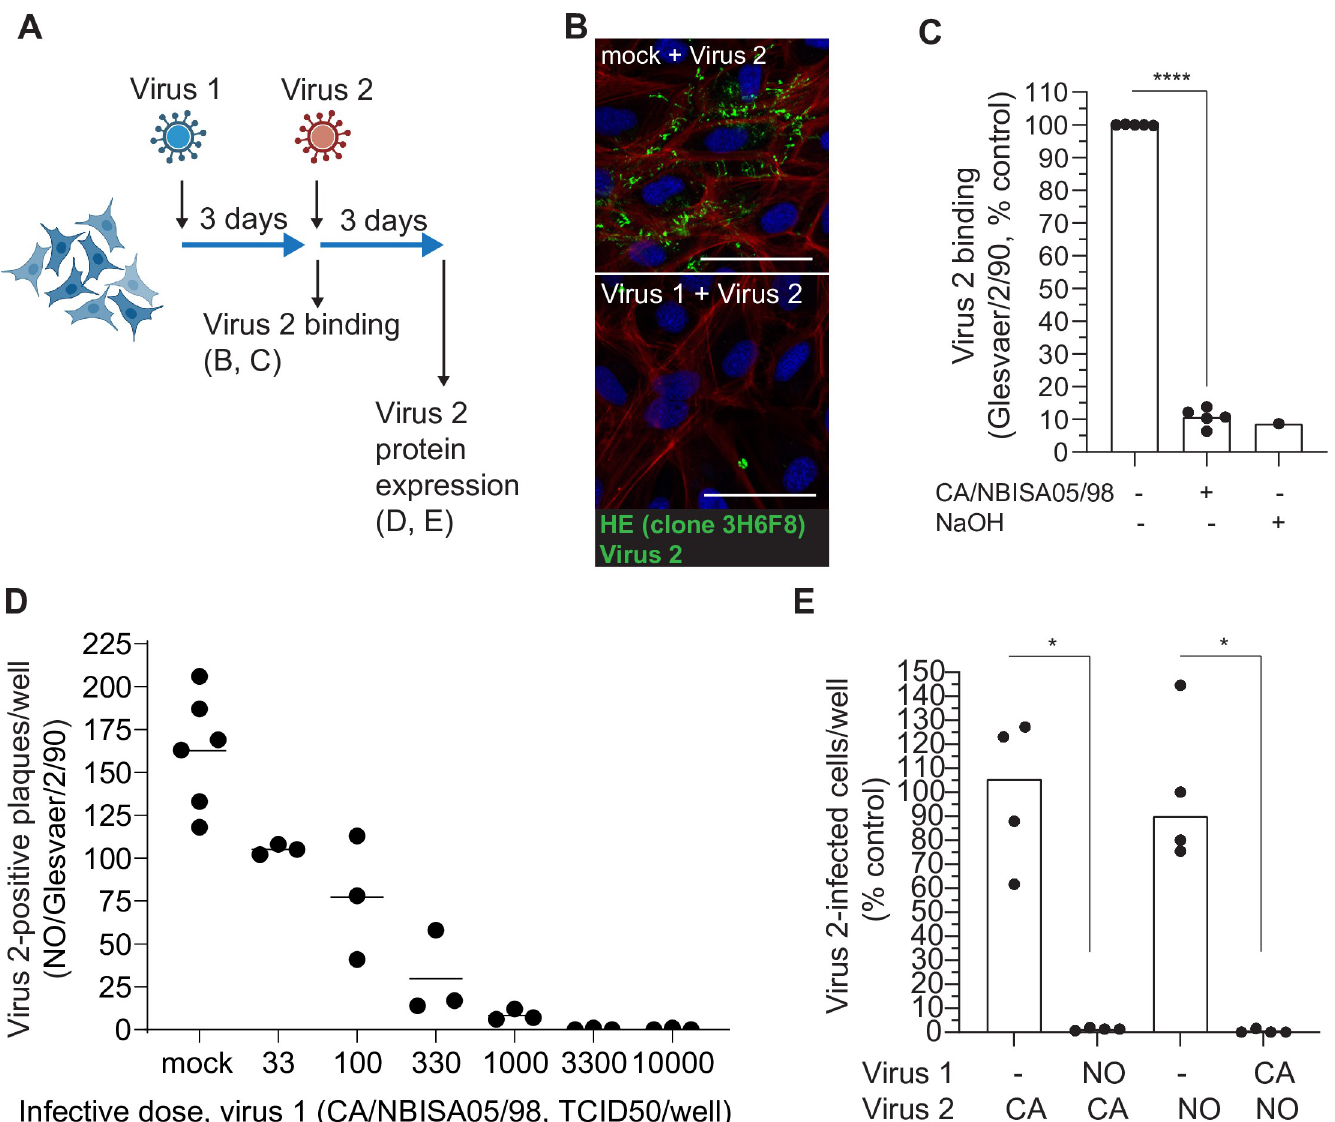
Fig 3. ISAV infection of ASK cells induces attachment interference. (A) ASK cells were infected with two antigenically distinct ISAV isolates 3 days apart, and binding and protein expression of the second isolate (virus 2) was evaluated by strain-specific antibodies. The illustration was created in Biorender.com. (B) NO/ Glesvaer/2/90 was allowed to bind the surface of non-infected (mock + virus 2) and CA/NBISA05/98-infected (virus 1 + virus 2, 3 d.p.i.) ASK cells for one hour, before extensive washing and detection by immunostaining for ISAV HE (green). Phalloidin (red) and Hoechst 33342 (blue) were used to visualise actin fibres and nuclei. Scale bars are 50 μ M. Micrographs are representative of two experiments. (C) Virus binding assay quantifying NO/Glesvaer/2/90-binding to non-infected and CA/ NBISA05/98-infected (3 d.p.i.) ASK cells. Cells treated with NaOH to remove the ISAV receptor are included as negative controls. Dots show normalised means from four independent experiments. Bars show the mean of means. ���� p < 0.0001, paired two-tailed t test. (D-E) ISAV infection interferes with a second ISAV infection 3 days later. (D) Counts of NO/Glesvaer/2/90 (virus 2) HE-positive plaques 3 d.p.i. in ASK cells infected with serial dilutions of CA/NBISA05/98 (virus 1) 3 days prior to the second infection. Dots show values from individual wells in one experiment. Bars show mean values. (E) The effect of infection with virus 1 on virus 2 protein expression 3 days later. (NO/Glesvaer/2/90 [NO], CA/NBISA05/98 [CA]). The numbers of HE-positive plaques per well were counted manually in 10 microscope fields per well, and normalised to the mean of wells not previously infected. Dots show normalised mean values per well in one representative experiment of three. � p < 0.05, Mann Whitney